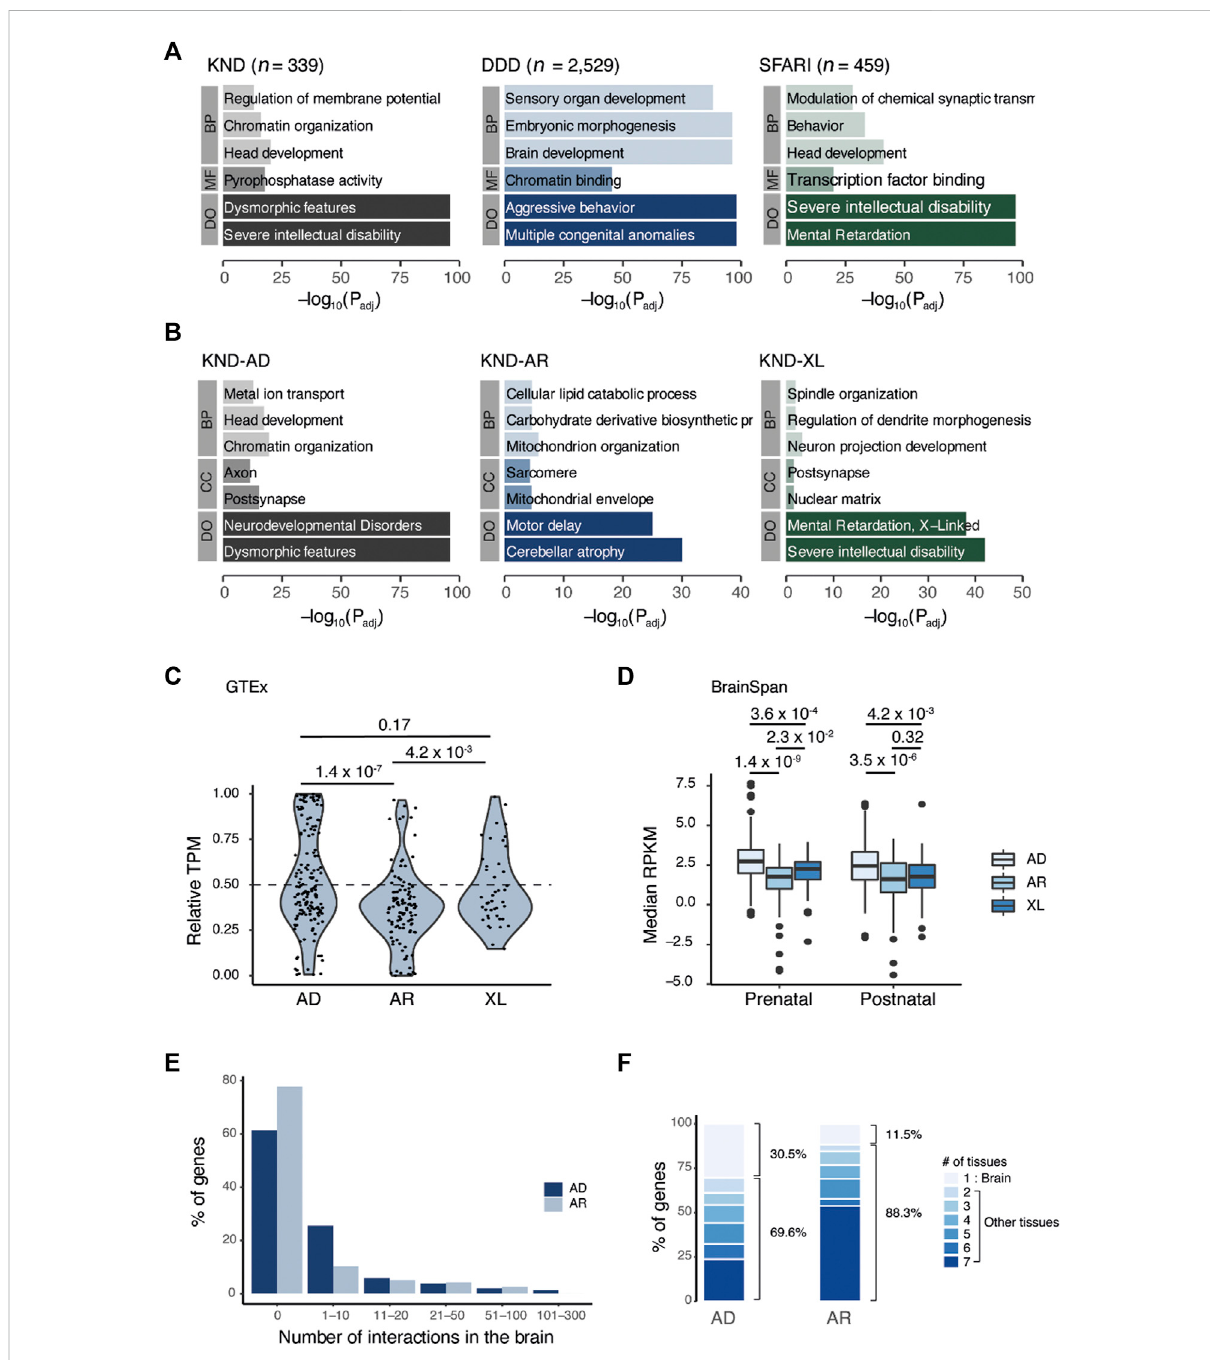
FIGURE 2 Comparative analysis of genes that cause neurodevelopmental disorders across inheritance patterns. (A) GO result of genes that led to the de fi nitivediagnosisin KND, DDD, and SFARI. (B) Breakdown ofKND genes byinheritancepattern. (C) Relative expressionofgenes inthebrain vs.the body (brain/body median TPM). (D) Boxplot of median gene expression in the brain for two developmental periods. (E) Proportion of genes having the given number of PPI events in brain tissue. (F) Proportion of genes having the given number of PPI-positive tissues. Tissues that correspond to two to seven are heart, kidney, liver, lung, muscle, and thymus. BP, biological process; CC, cellular component; MF, molecular function; DO, disease ontology; AD, autosomal dominant; AR, autosomal recessive; XL,